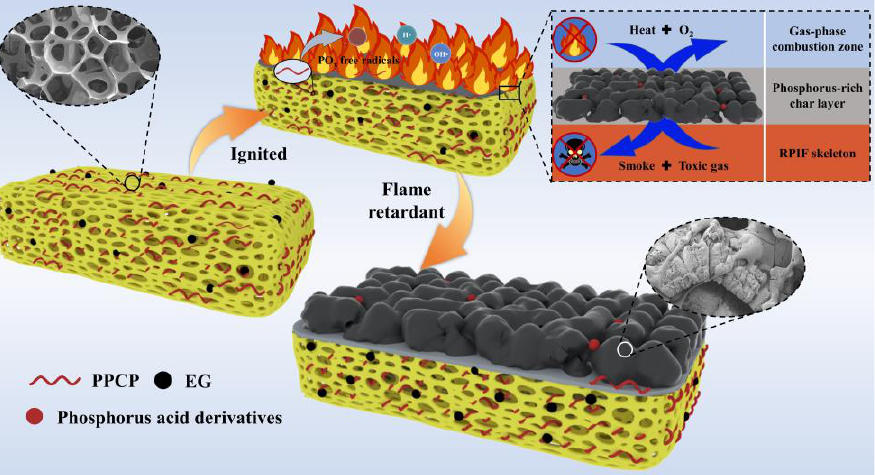
Figure 15. Schematic illustration for flame-retardant and smoke-suppressant effect mechanisms of